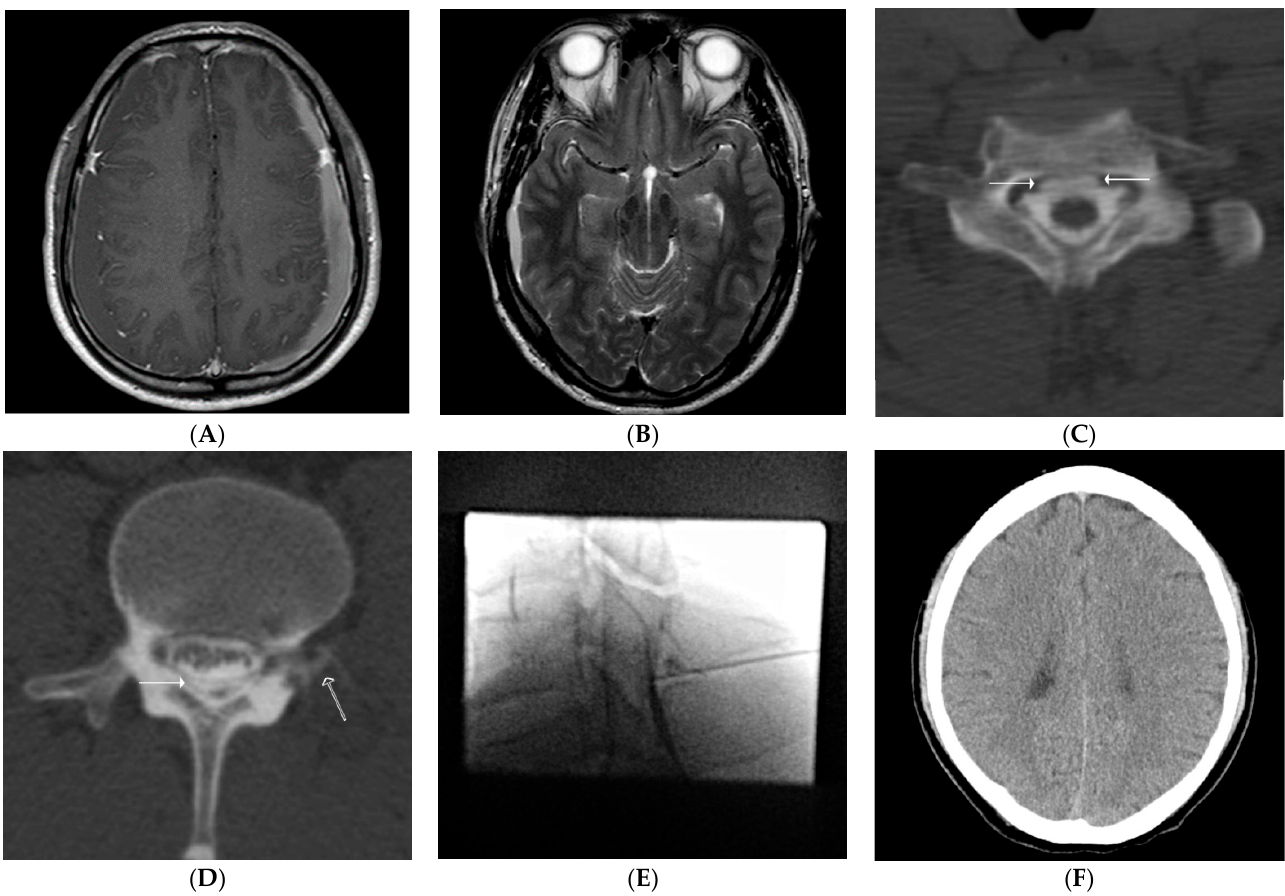
Figure 3. ( A – F ). Findings for a representative case involving a 41 ‐ year ‐ old man with nontraumatic intracranial subdural hematoma (SDH) . The patient presented with a chief complaint of headache not related to a specific posture. ( A ). Contrast ‐ enhanced, fat ‐ suppressed T1 weighted image shows bilateral nontraumatic SDH with pachymeningeal thickening and enhancement. ( B ). T2 weighted image at the initial presentation shows cisternal obliteration. ( C , D ). Computed tomography (CT) myelography performed to evaluate possible spontaneous intracranial hypotension shows cerebrospinal fluid leaks at the level of the C6/7 ventral epidural space (solid arrows, Figure 3C), the L2/3 dorsal epidural space (a solid arrow, Figure 3D), and the left extraforaminal space (a hollow arrow, Figure 3D). ( E ). Subsequent epidural blood patch is per ‐ formed at the C6/7 and L2/3 (not shown) levels. ( F ). Follow ‐ up brain CT performed after 3 months shows no evidence of SDH.